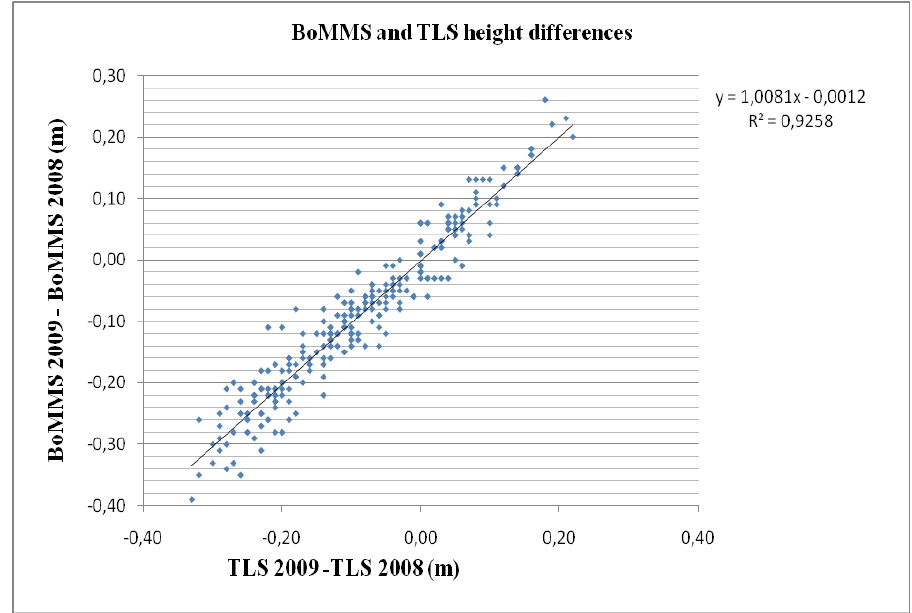
Figure 6. Correlation between TLS- and BoMMS-derived elevation